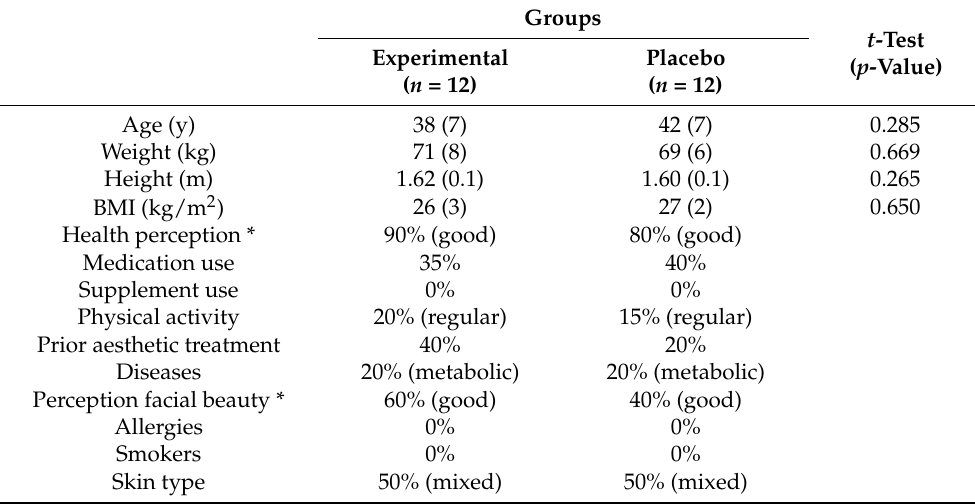
Table 1. Participant